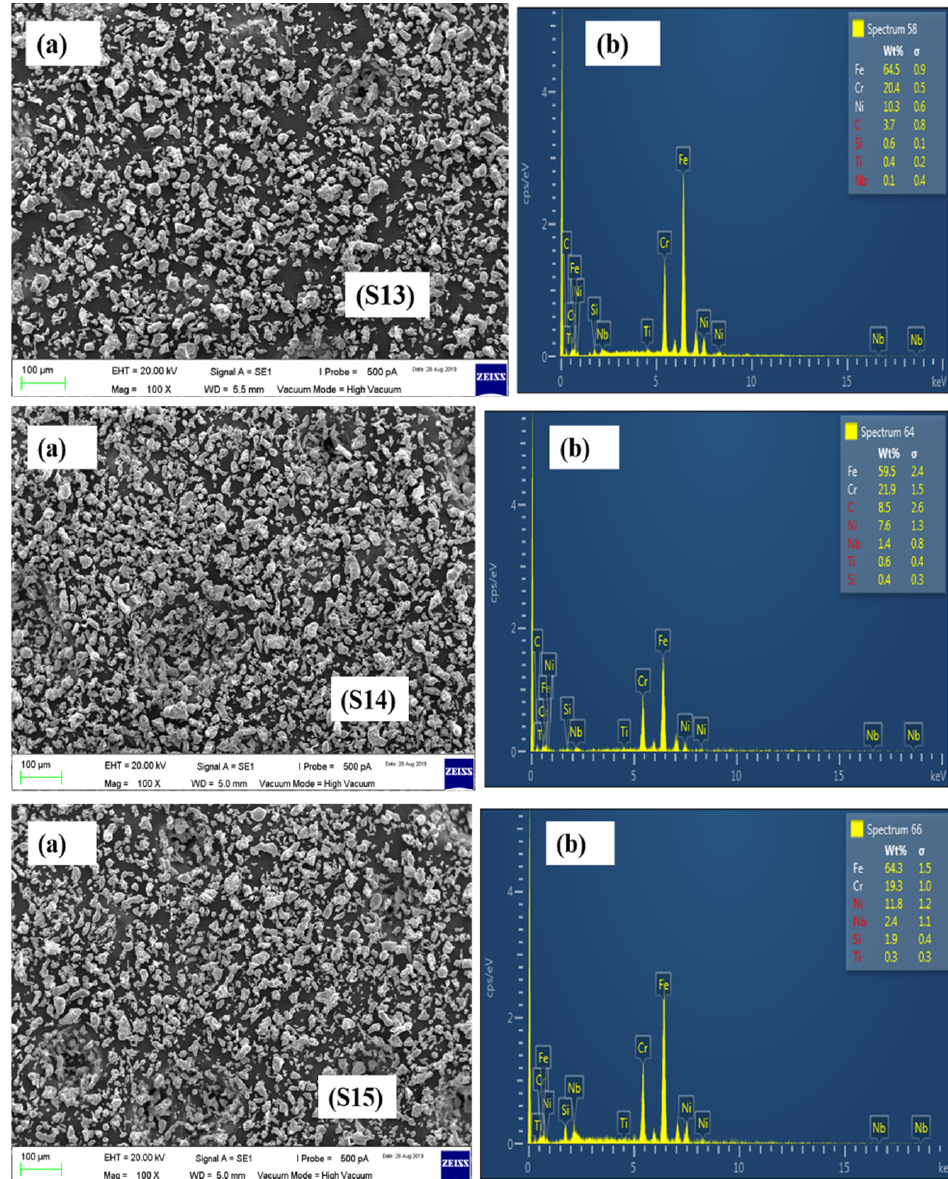
Figure 8. SEM images of S13, S14, and S15 powder formulations.